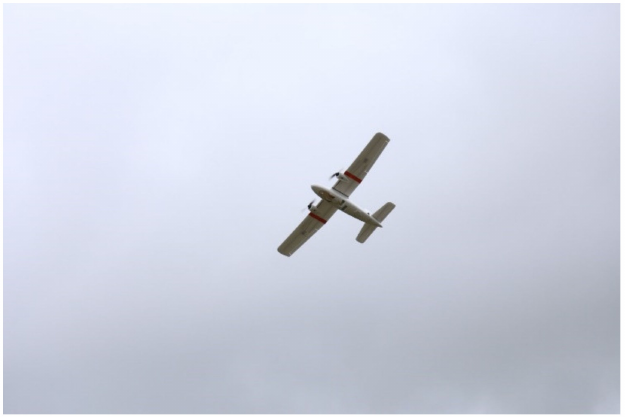
Figure 1. Figure of an electric fixed-wing